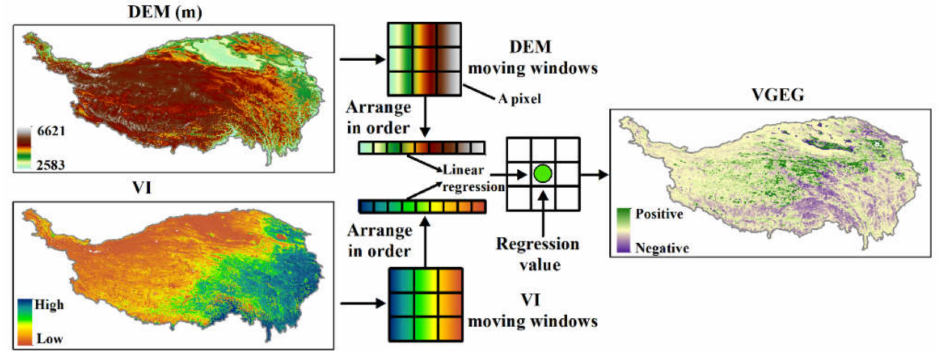
Figure 2. Diagram of the calculation of VGEG. Here, we take a 3 × 3 window as an